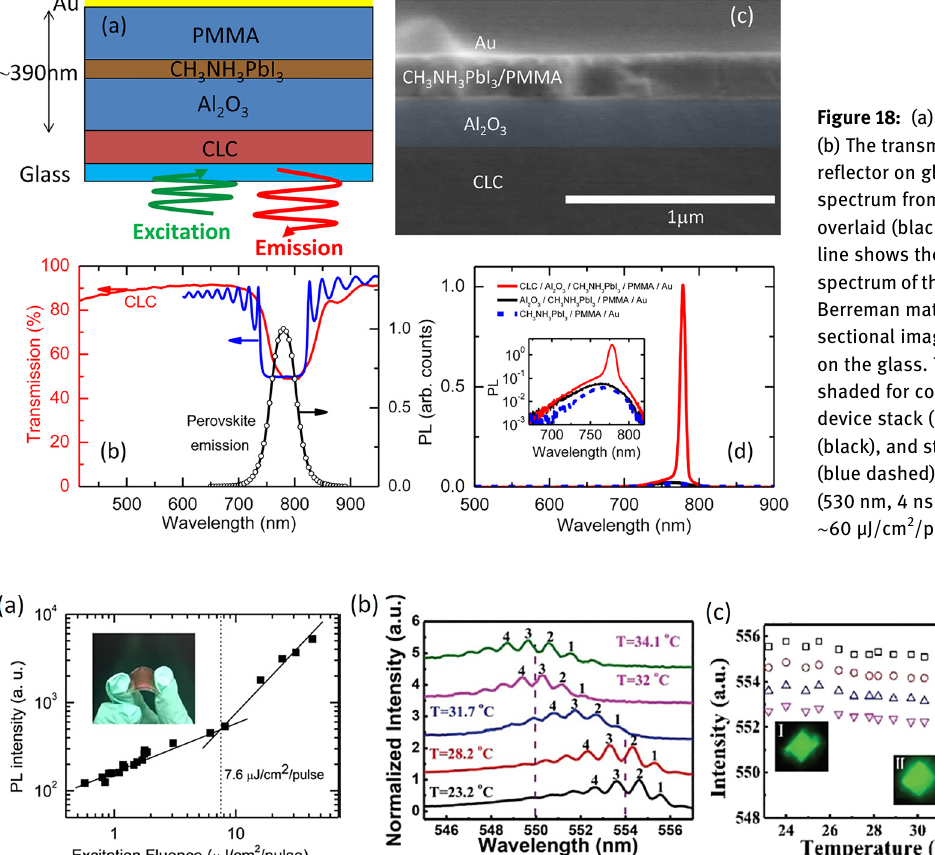
Figure 19: (a) Extracted emission intensity from a device stack fabricated on a flexible 80% CLC reflector following photoexcitation at a range offluences(532nm,5nspulses,100-Hzrepetitionrate).TheASEtransition fl uenceisdeterminedtobe7.6 μ J/cm 2 /pulse.Inset:photographof the fl exibledevice[144].(b)The laserspectraofliquidcrystal-covered perovskitemicrodisksat differenttemperatures.(b)The peakpositions of modes in (c) as a function of temperature. A dramatic wavelength shift can be observed at T = 32 ° C